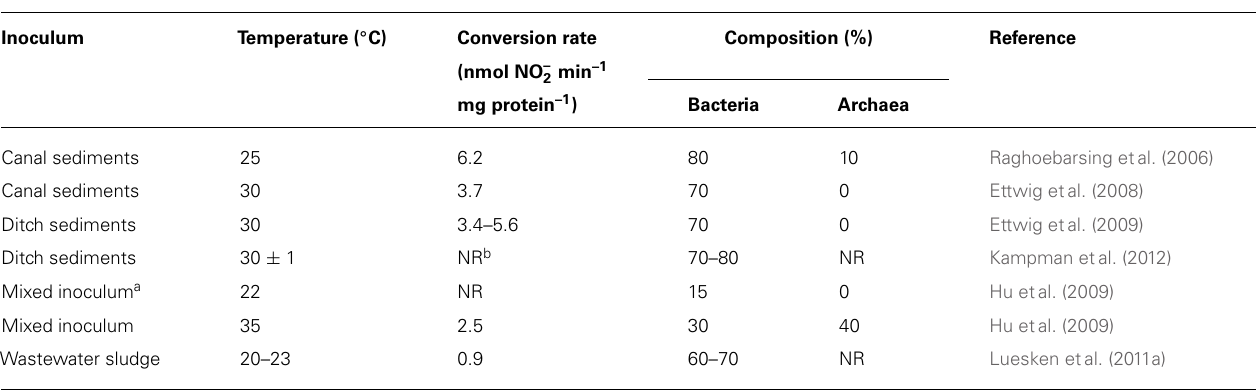
Table 1 |The reported enrichment cultures of M. oxyfera